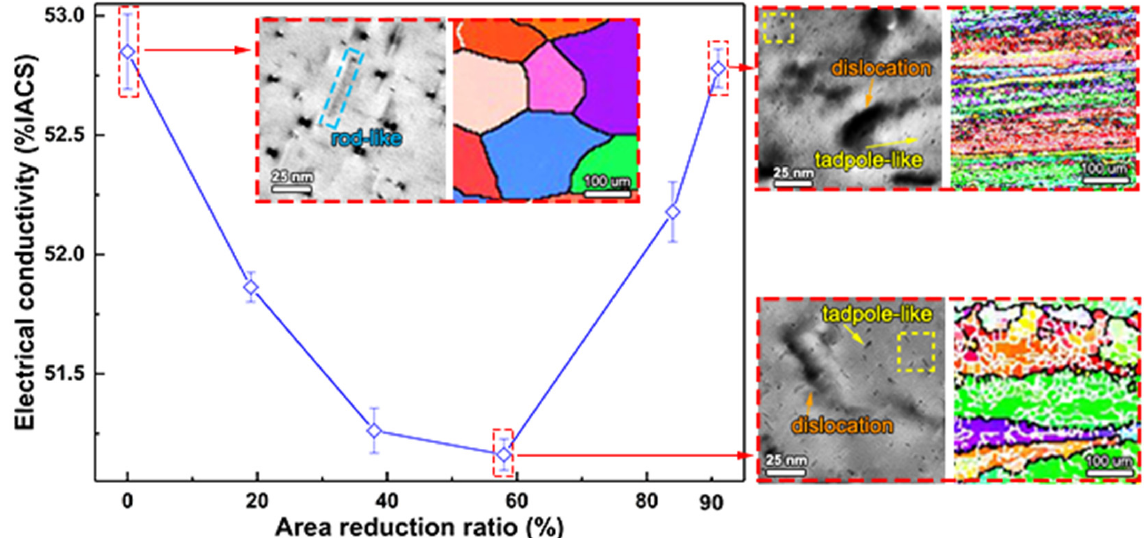
Figure 5. Variations of electrical conductivity with different area reduction ratio of the Al-Mg-Si-Cu alloys. The corresponding TEM images and EBSD microstructure are depicted as an inset.